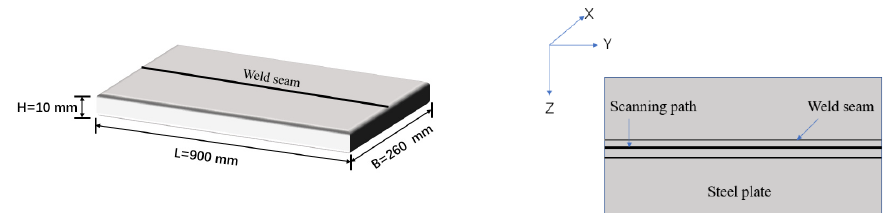
Figure 4. Welding defect components.